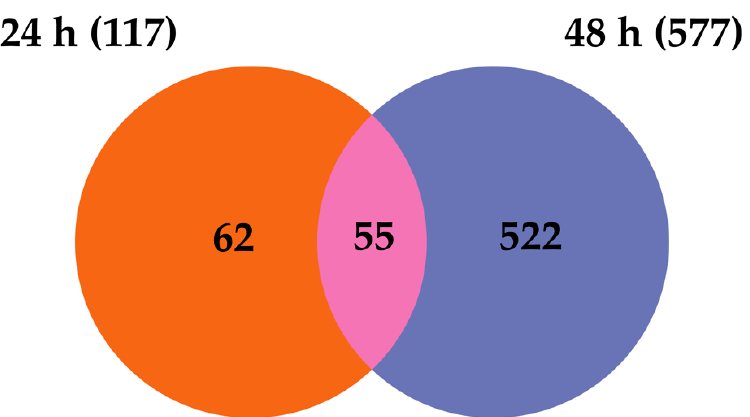
Figure 5. Gene ontology enrichment analysis for biological processes after WNV infection. ( A ) GO Slim terms for up-regulated transcripts. ( B ) GO slim terms for down-regulated transcripts.